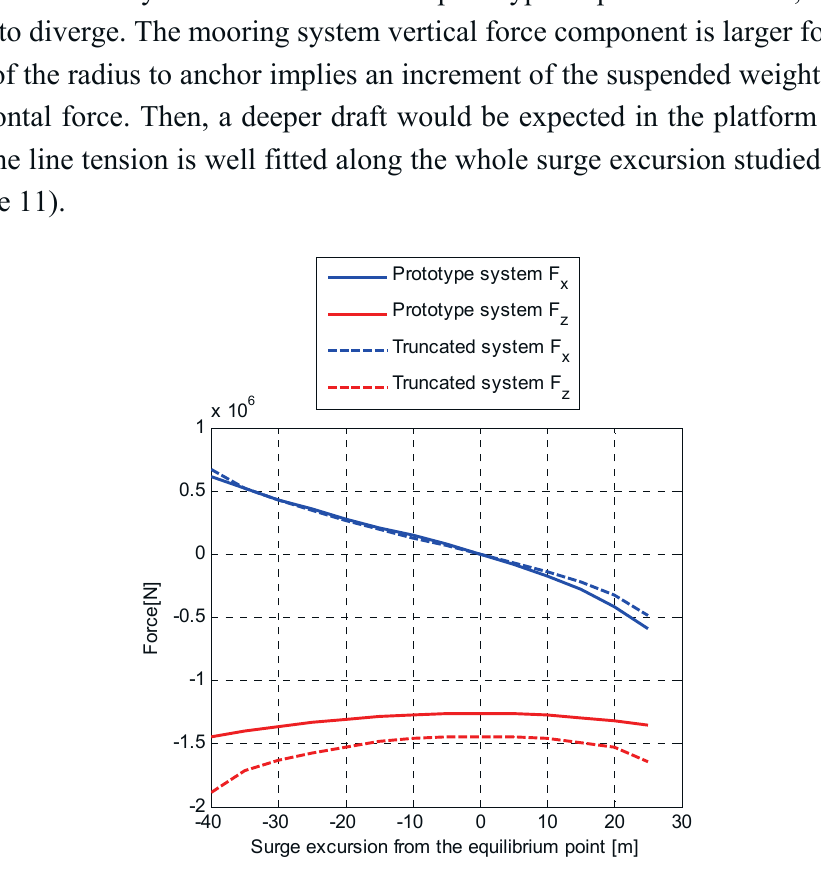
Figure 10. Mooring system response